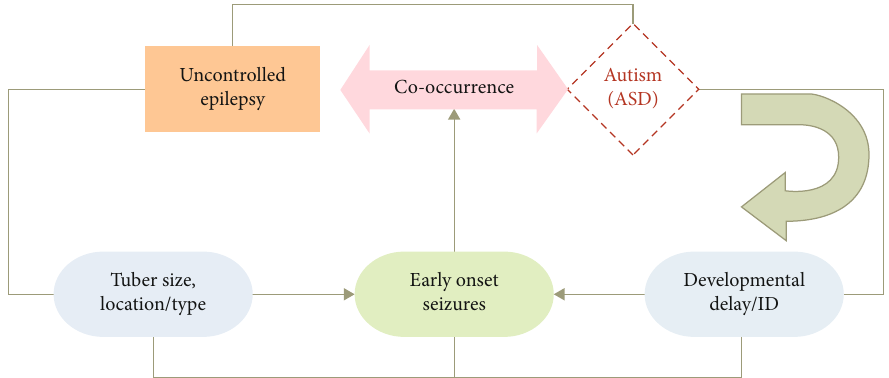
Figure 3: Signi fi cant characteristics in TSC. This demonstrates the correlation between phenotypic characteristics and predictive risk factors in patients with TSC.